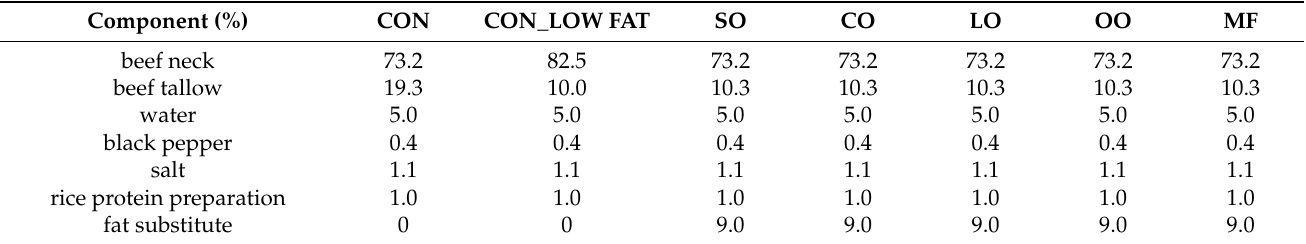
Table 1. The recipe ingredients of the control group beef burgers (CON), burgers with reduced fat (CON_LOW FAT), burgers with fat substitutions, i.e., sunflower oil (SO), canola oil (CO), linseed (LO), olive oil (OO) and milk fat